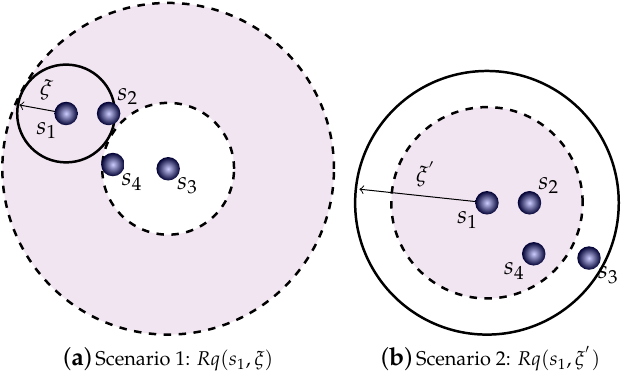
Figure 1. Example of queries where the lower bound and the upper bound properties can be used to avoid unnecessary distance